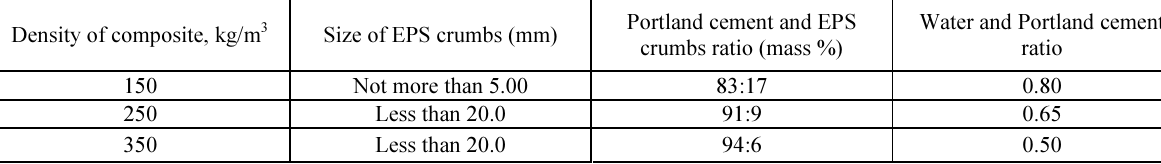
Table 2. Compositions of formative mixtures of lightweight composite with different densities Density of composite, kg/m